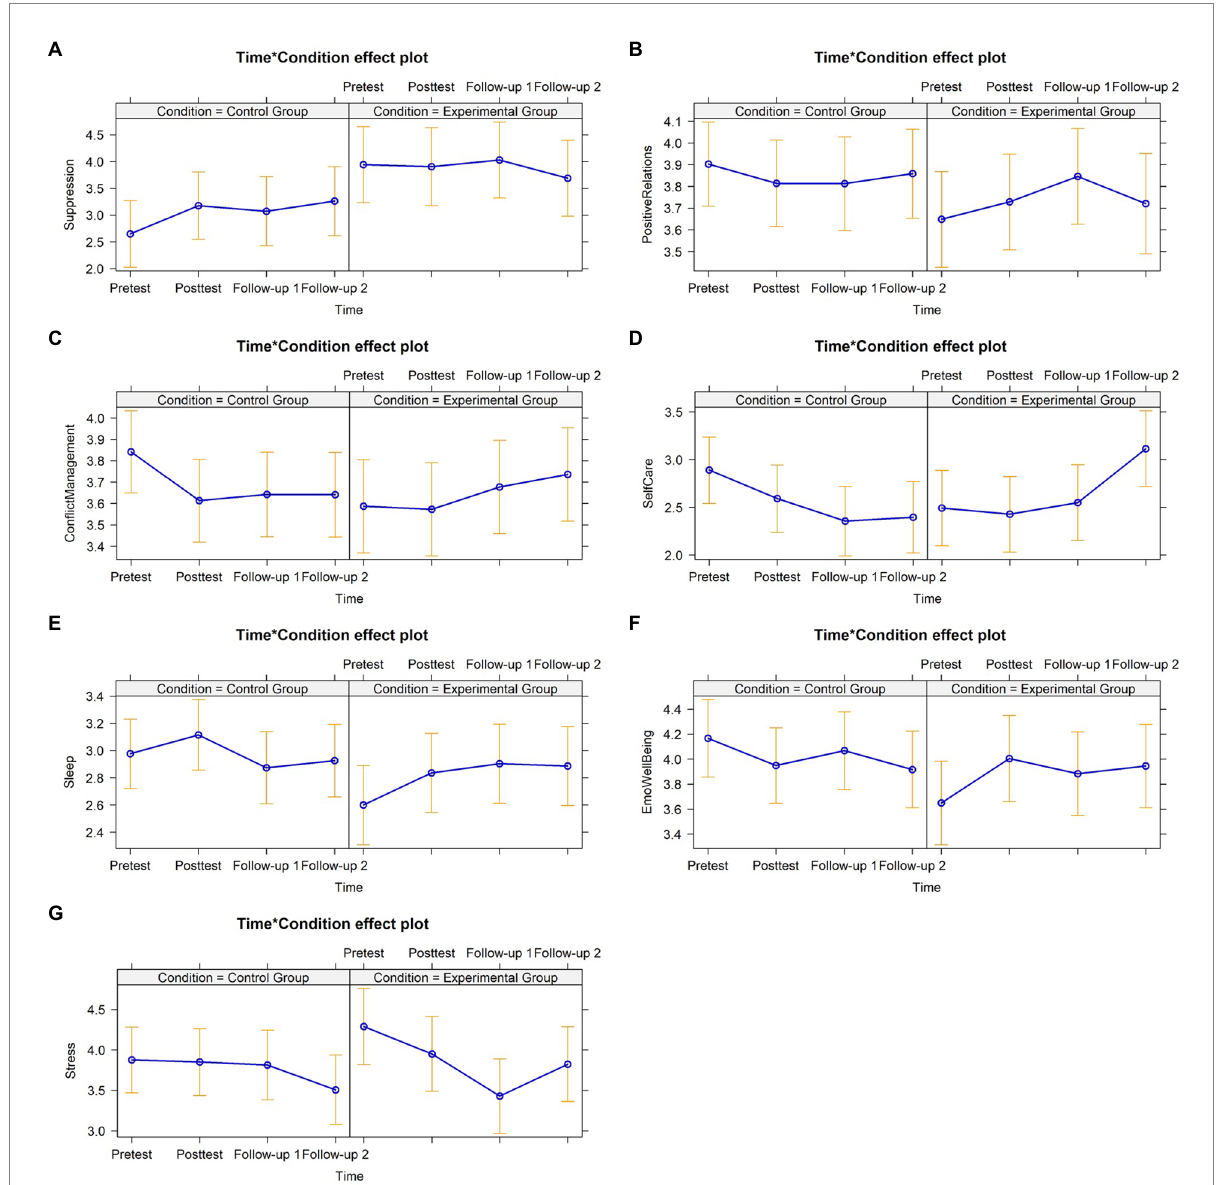
FIGURE 5 Graphical representation of interaction effects (Time*Treatment Condition) on proximal and distal dependent variables – Cluster C. (A) Expressive suppression depicting a significant effect at follow-up 2 ( B = − 0.93, SE = 0.38, 95% CI [ − 1.66, − 0.19], f 2 = − 0.69). (B) Positive relationship skills depicting a significant effect at follow-up-1 ( B = 0.32, SE = 0.13, 95% CI [0.07, 0.58], f 2 = 0.74). (C) Conflict management skills depicting a significant effect at posttest ( B = 0.21, SE = 0.11, 95% CI [0.03, 0.43], f 2 = 0.48), follow-up 1 ( B = 0.29, SE = 0.11, 95% CI [0.07, 0.51], f 2 = 0.65) and follow-up 2 ( B = 0.35, SE = 0.11, 95% CI [0.13, 0.56], f 2 = 0.78). (D) Self-care practices depicting a significant effect at follow-up 1 ( B = 0.59, SE = 0.24, 95% CI [0.13, 1.06], f 2 = 0.67) and follow-up 2 ( B = 1.12, SE = 0.24, 95% CI [0.64, 1.59], f 2 = 1.27). (E) Sleep quality depicting a significant effect at follow-up 1 ( B = 0.41, SE = 0.17, 95% CI [0.08, 0.74], f 2 = 0.60) and follow-up 2 ( B = 0.34, SE = 0.17, 95% CI [0.01, 0.67], f 2 = 0.50). (F) Emotional well-being depicting a significant effect at posttest ( B = 0.57, SE = 0.21, 95% CI [0.16, 0.99], f 2 = 0.78) and follow-up 2 ( B = 0.54, SE = 0.21, 95% CI [0.13, 0.95], f 2 = 0.74). (G) Occupational stress depicting a significant effect at follow-up 1 ( B = − 0.80, SE = 0.34, 95% CI [ − 1.46, − 0.13], f 2 = − 0.83).